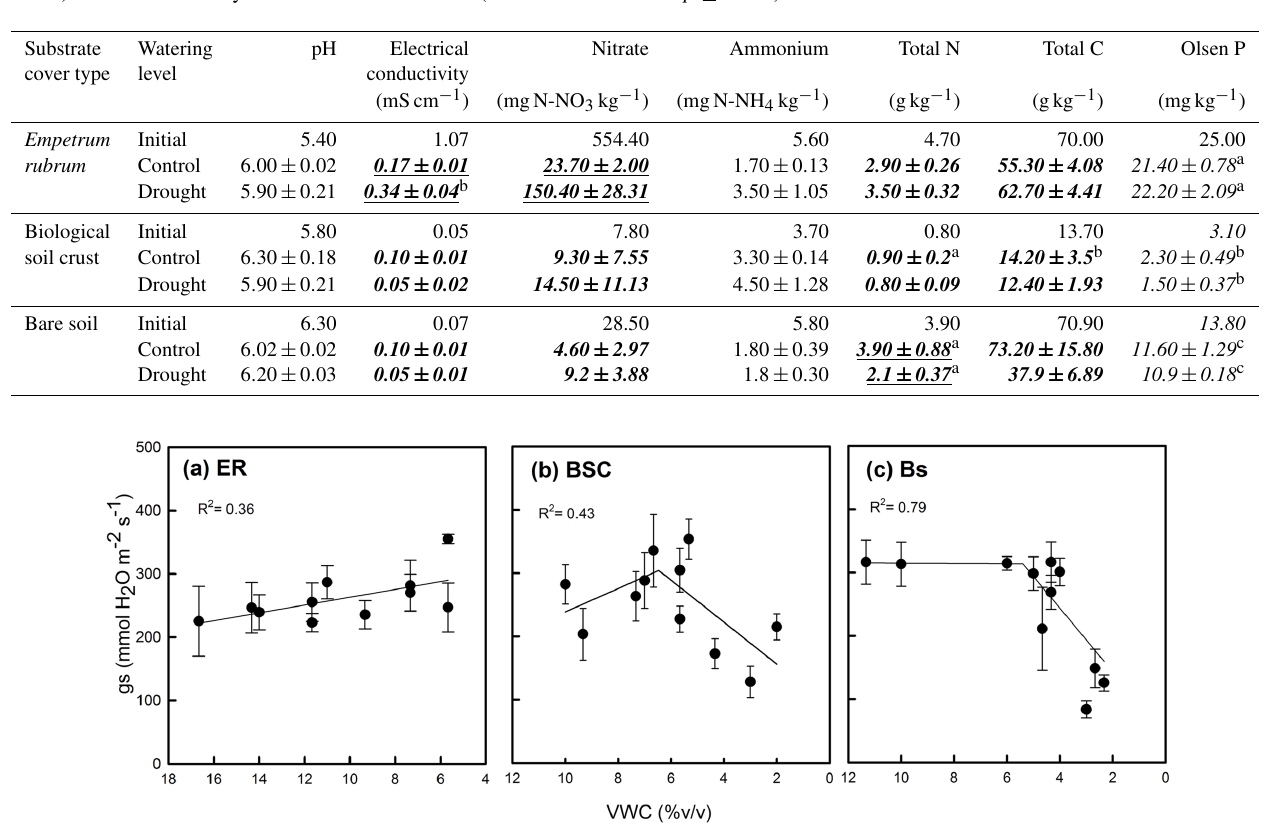
Table 1. Properties of bare soil and soils covered by biological soil crust and Empetrum rubrum before (initial) and after applying a full watering (control) and a partial soil drying regimen (drought) during a 38-day period. Values are means ± 1 standard error ( n = 3). Differences among final conditions were determined using two-way ANOVA followed by Bonferroni post hoc comparisons. Bold values represent significant interaction between substrate type and watering level ( p ≤ 0 . 05). Underlines and italics represent significance of simple main effects (watering level and substrate type, respectively) ( p ≤ 0 . 05). Within each column and substrate cover type, values sharing a letter (a, b or c) are not statistically different from each other (Bonferroni-corrected p ≤ 0 . 003).